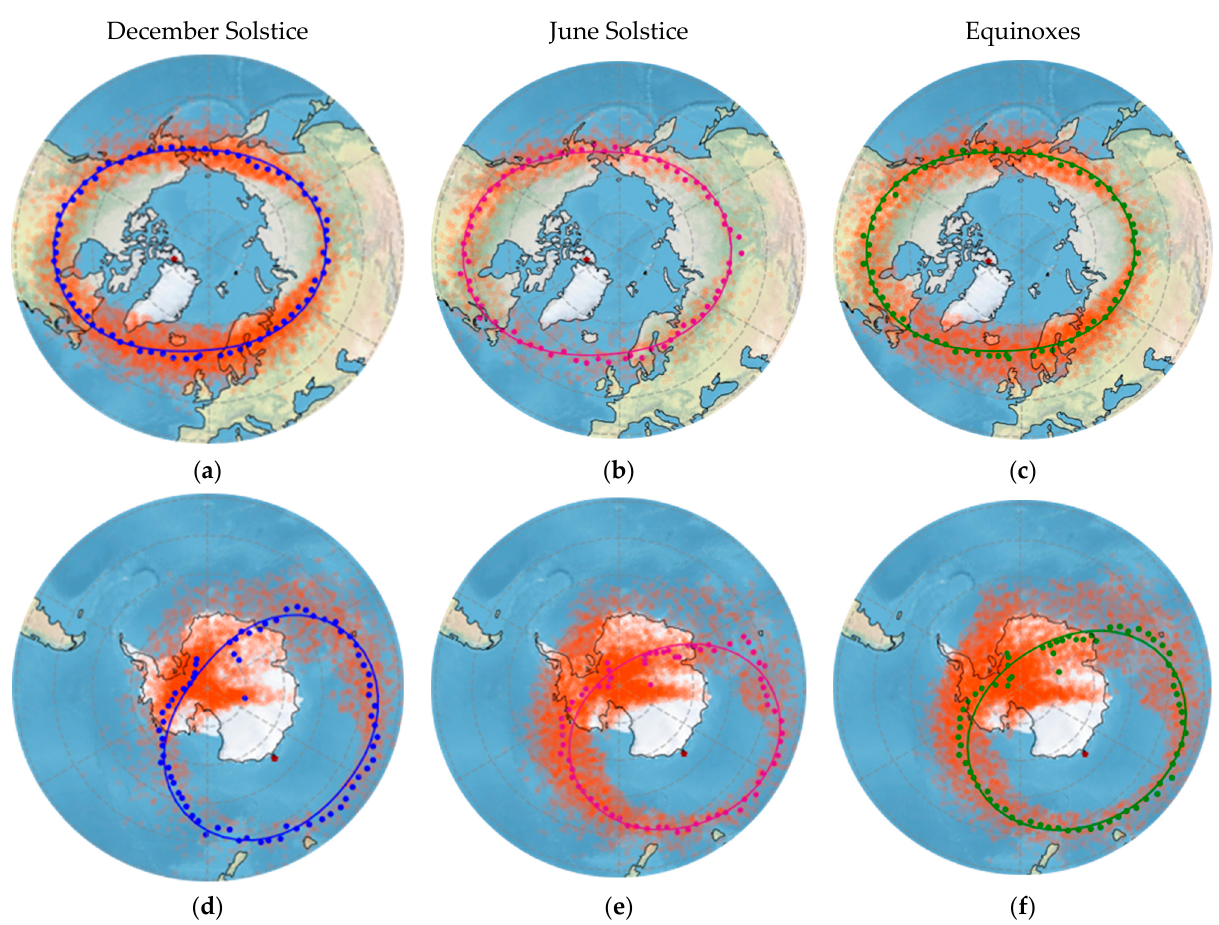
Figure 10. Ellipse distribution for the northern ( a – c ) and southern ( d – f ) hemispheres of the mean position of the trough minimum in three seasons: December solstice (blue color), June solstice (pink color), and equinoxes (green color). Red points in each hemisphere represents the detected trough minimum location. The dark red star shows the locations of the geomagnetic pole for each hemisphere. Table 2. Mean position of the trough minimum during December solstice, June solstice, and the equinoxes. The corresponding standard deviations are given after the ±